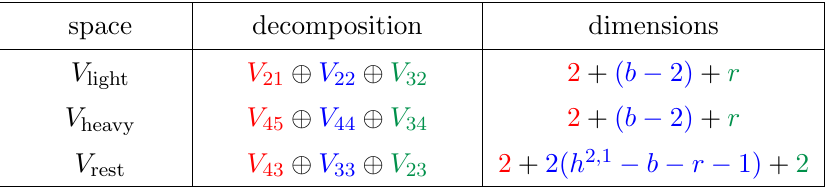
Table 7 . Decomposition of H 3 ( Y 3 ; R ) for II b ! III c